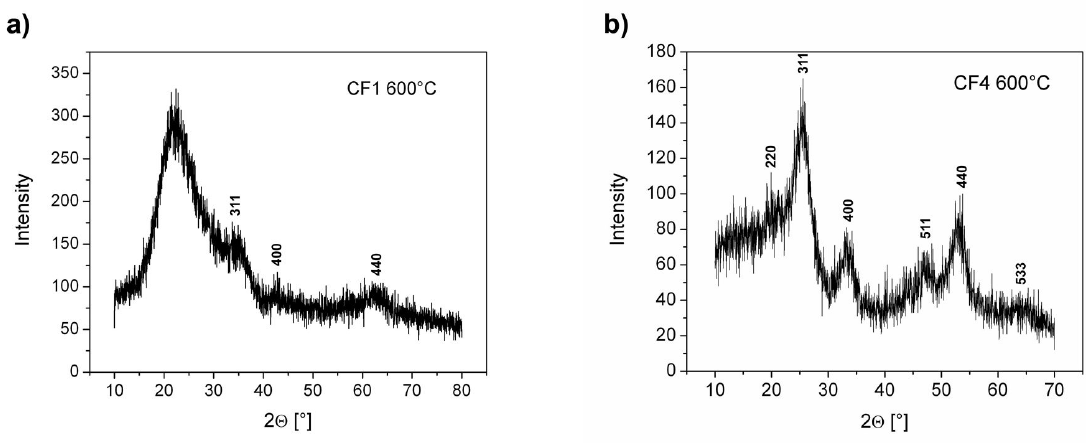
Figure 10. X-ray diffraction patterns of samples calcined at 600°C: a) silica core/monolayered cobalt ferrite (CF1-11); b) and silica core/ four-layered cobalt ferrite particles (CF4-11).